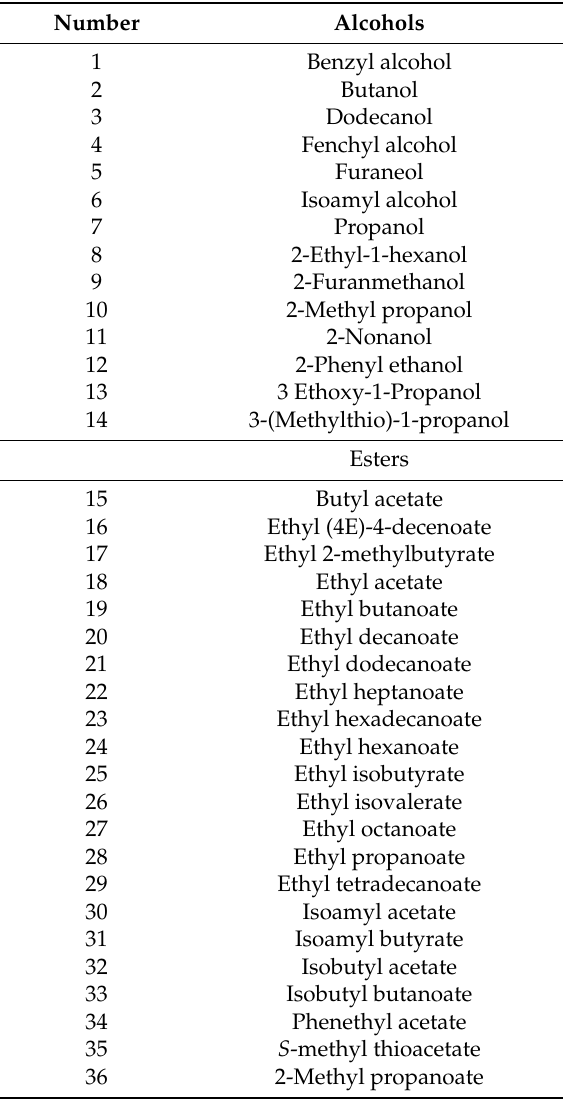
Table 2. List of 62 volatiles that were detected by GC/MS